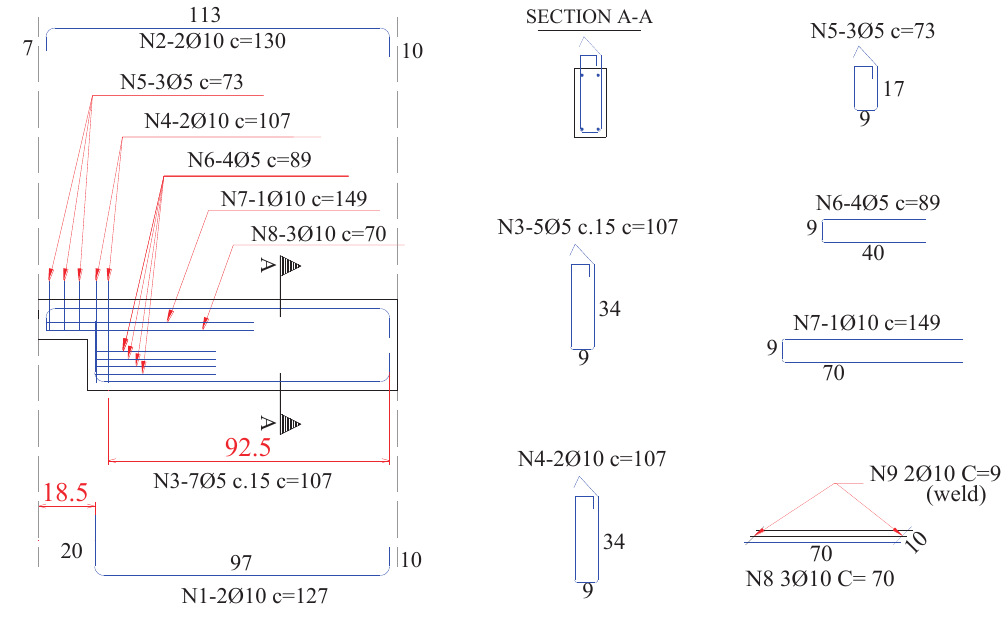
Details of the beams for all specimens (length dimensions in